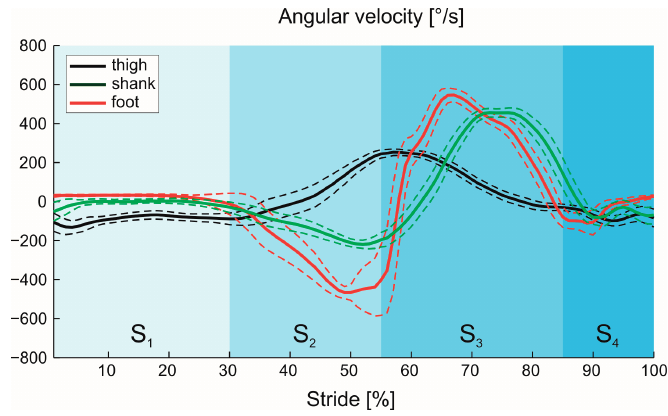
Figure 5. Participant #1: Mean and standard deviation of angular velocity of foot (red), shank (green) and thigh (black) partitioned into the four gait phases (S Off, S : Swing, S : Hell 3 4